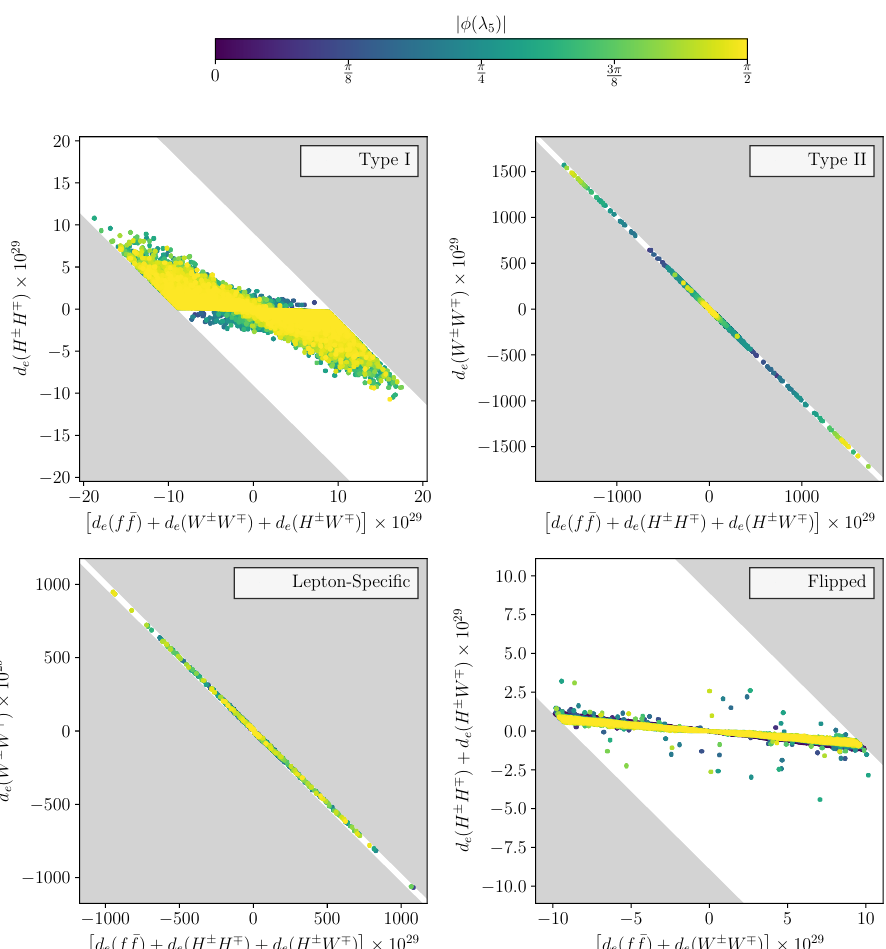
Figure 14 . Contributions to the EDM according to their relative sign in Type I (top left), Type II (top right), Lepton-Speci(cid:12)c (bottom left) and Flipped (bottom right). The colour code represents the absolute value of the magnitude of (cid:30) ( (cid:21) ). The grey shaded regions represent the parameter 5 space excluded by the EDM constraints only. The coloured points are the ones that passed all the constraints, that is, EDMs plus theoretical and all other experimental